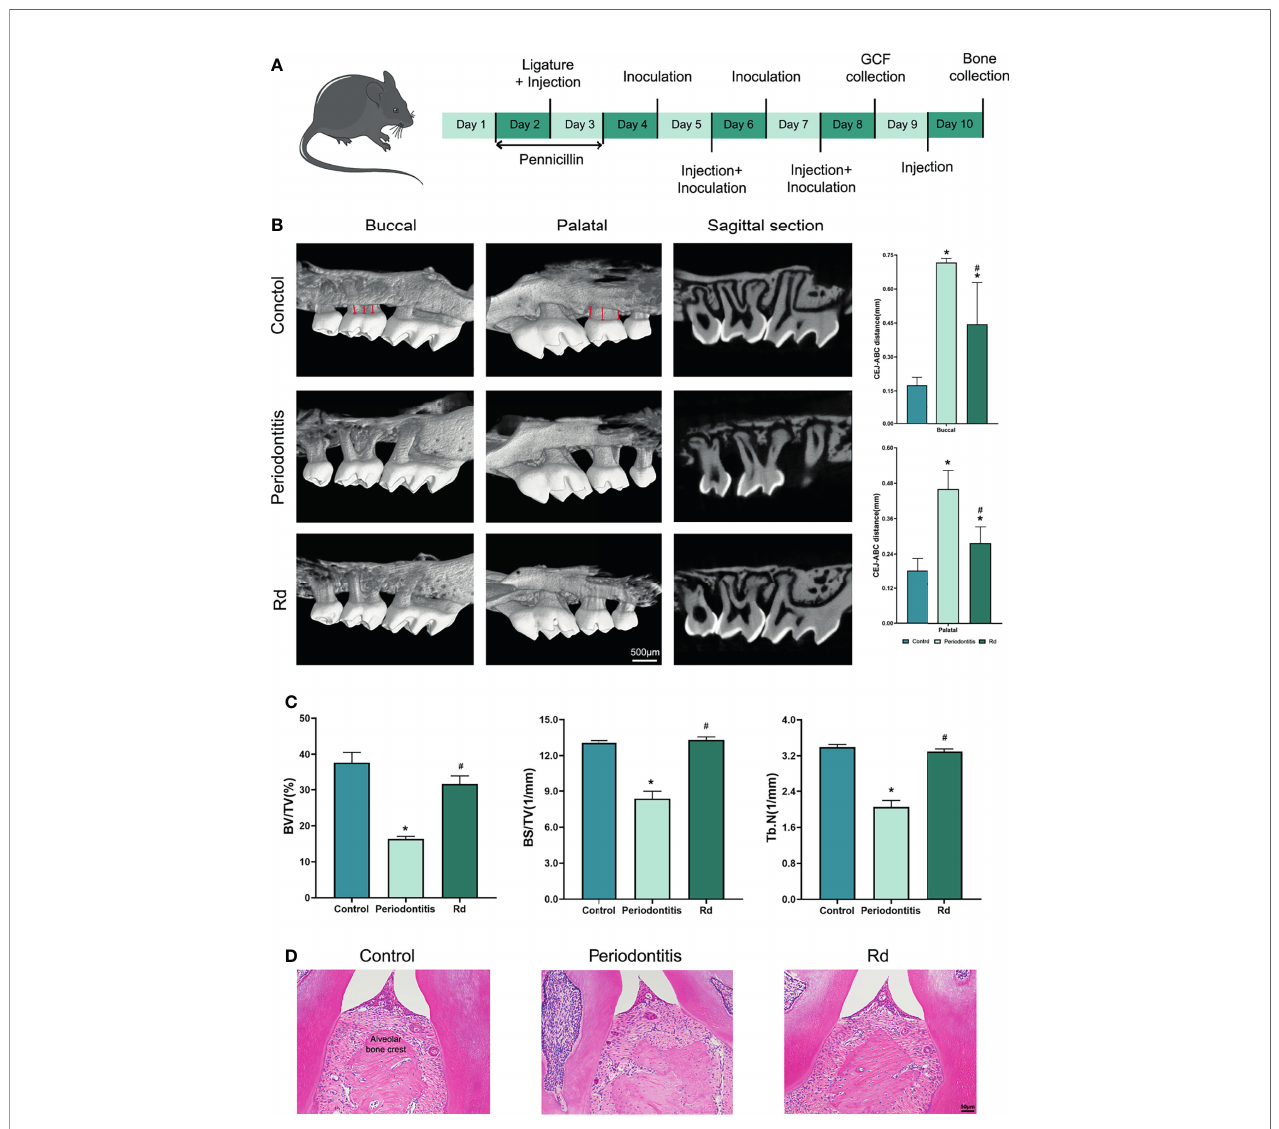
FIGURE 5 | Ginsenoside Rd led the alleviation of bone resorption in vivo . (A) The sketch of the animal experiment. (B) Reconstructed images of the alveolar bones of mice were obtained by micro-CT scanning. The CEJ – ABC distance was indicated by the red lines and was measured according to the scale. (C) Bone histomorphometry indexes (BV/TV, BS/TV, and Tb.N) in the ROI. The results are shown as mean ± SD ( n = 3). * p < 0.05 versus the normal control; # p < 0.05 versus the periodontitis group. (D) HE staining of the periodontal tissues of